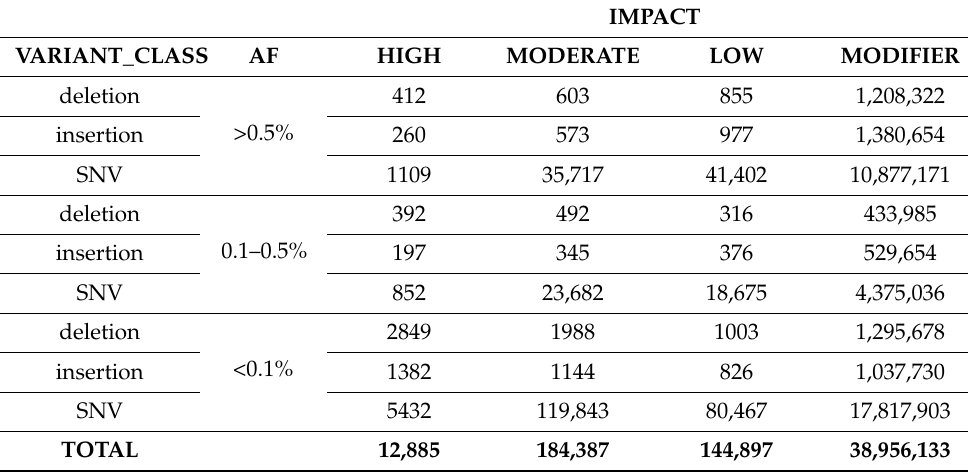
Table 1. Summary of variant counts in three allele frequency tiers (>0.5%; 0.1–0.5%; <0.1%). Variant impact categories follow VEP classification: HIGH—disruptive impact on the protein; MODERATE— non-disruptive variant that might change protein effectiveness; LOW—harmless or unlikely to change protein behaviour; MODIFIER—noncoding sequence